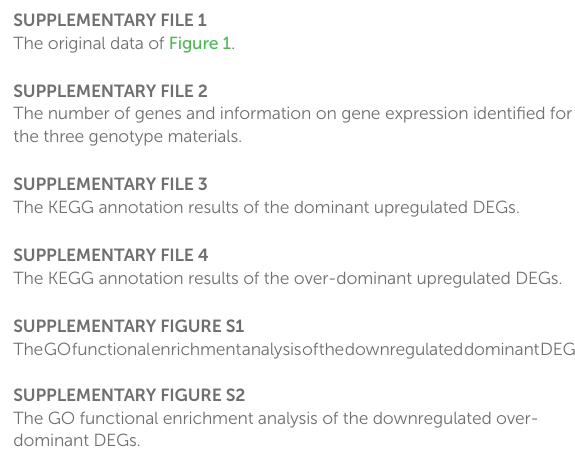
SUPPLEMENTARY FIGURE S1 The GO functional enrichment analysis of the downregulated dominant DEGs. SUPPLEMENTARY FIGURE S2 The GO functional enrichment analysis of the downregulated over- dominant